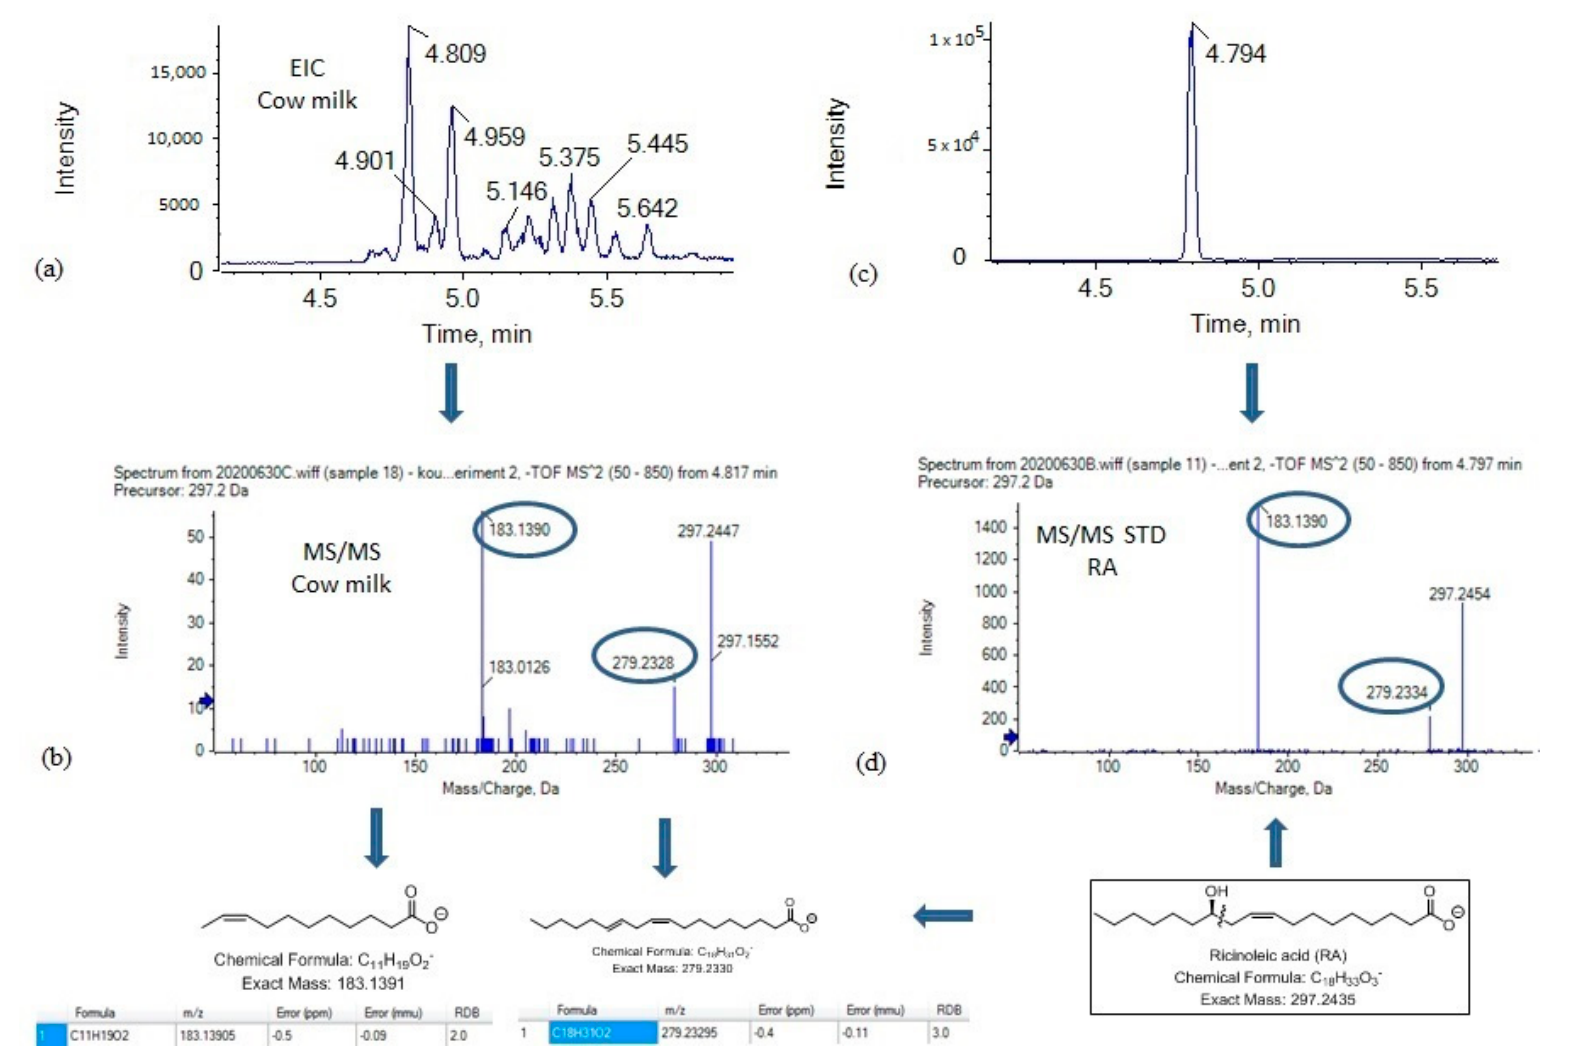
Figure 2. Mass spectrometry analysis of ricinoleic acid in cow milk. ( a ) EIC of OSAs ( m/z 297.2435) in a representative cow milk sample: ( b ) MS/MS spectrum of the precursor ion [M − H] − ; ( c ) EIC of standard ricinoleic acid; ( d ) MS/MS spectrum of standard ricinoleic acid.